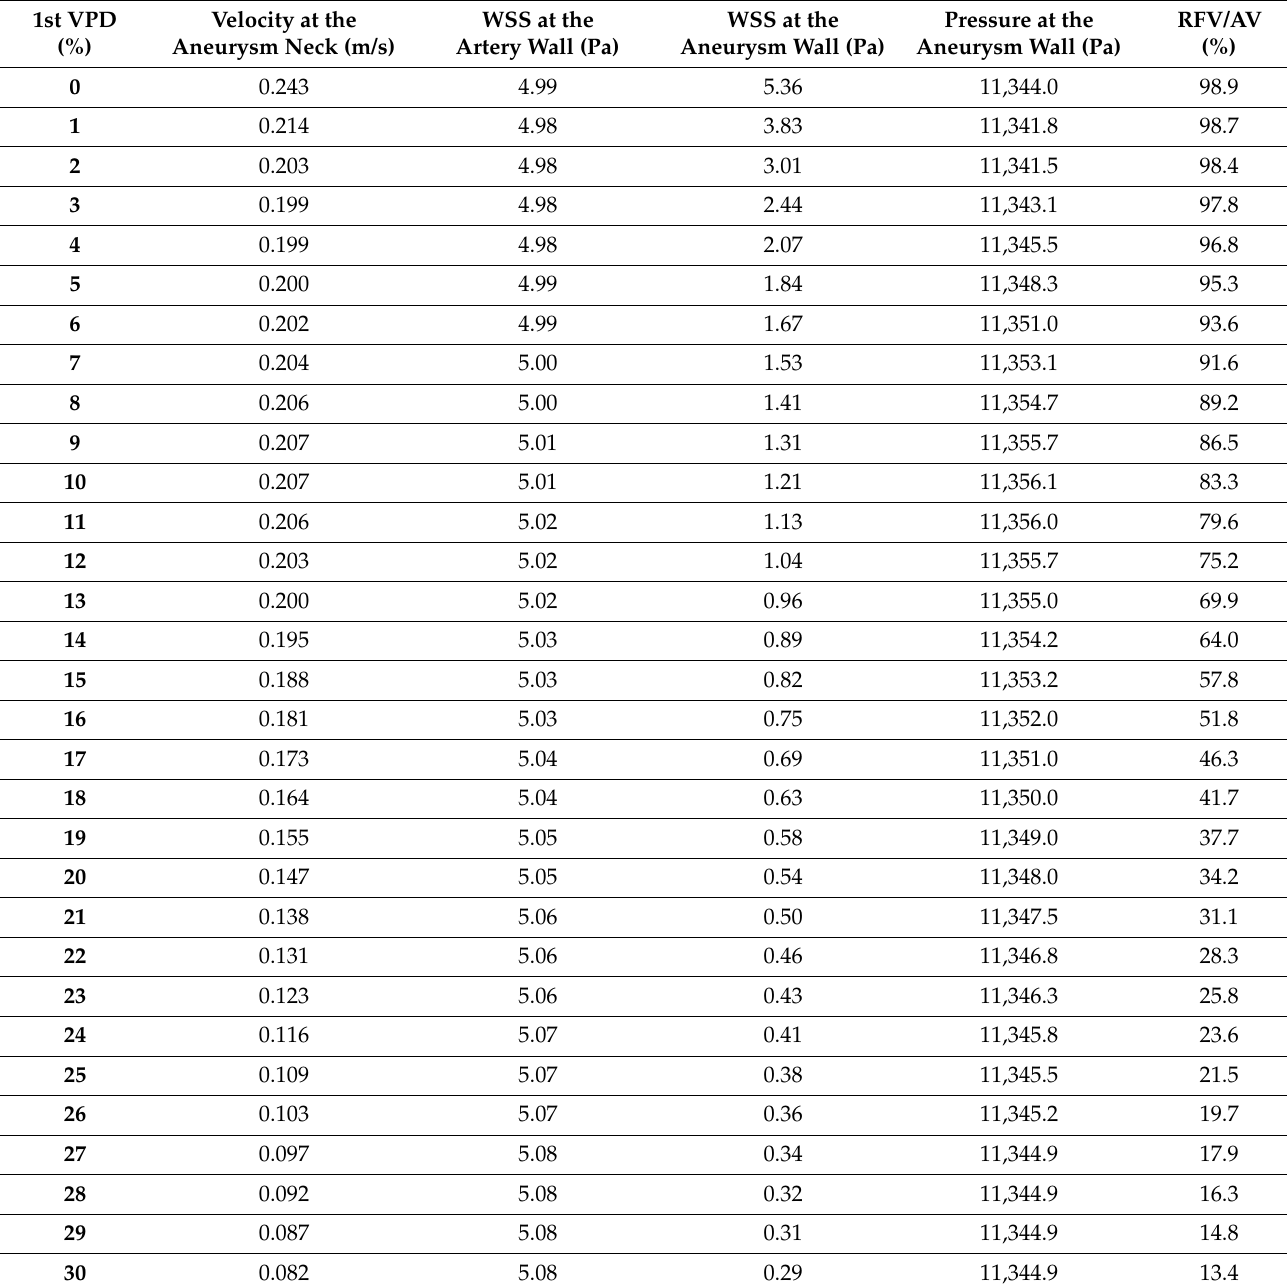
Table 6. Numerical results obtained for each 1st VPD value; stationary